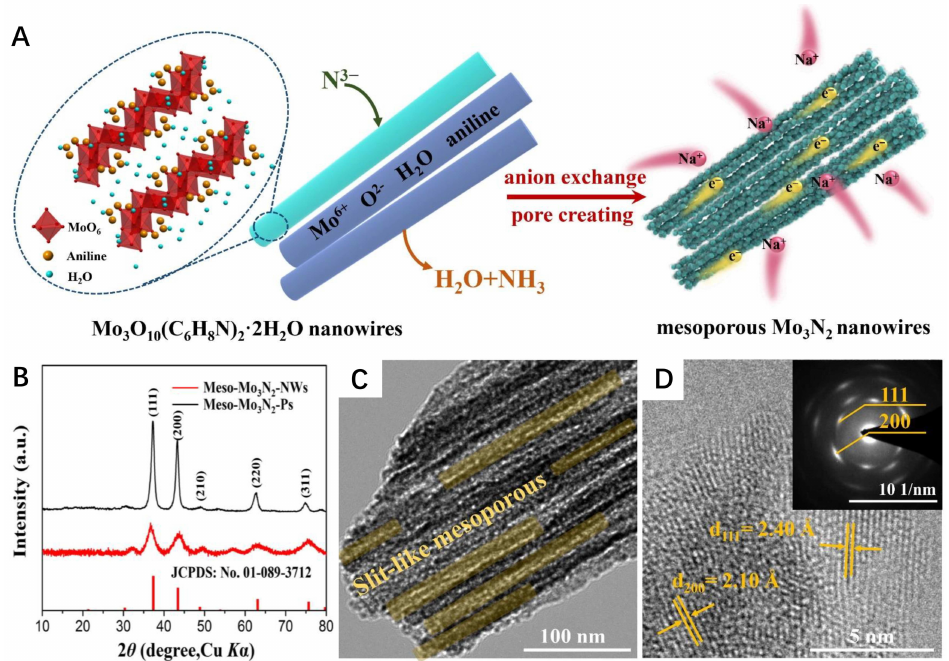
Figure 2. ( A ) Schematic of the formation of Meso-Mo 3 N 2 -NWs; ( B ) XRD patterns of the Meso-Mo 3 N 2 - Ps and Meso-Mo 3 N 2 -NWs; TEM ( C ) and HRTEM ( D ) images of Meso-Mo 3 N 2 -NWs. Reproduced with permission from [40]. Copyright © 2021